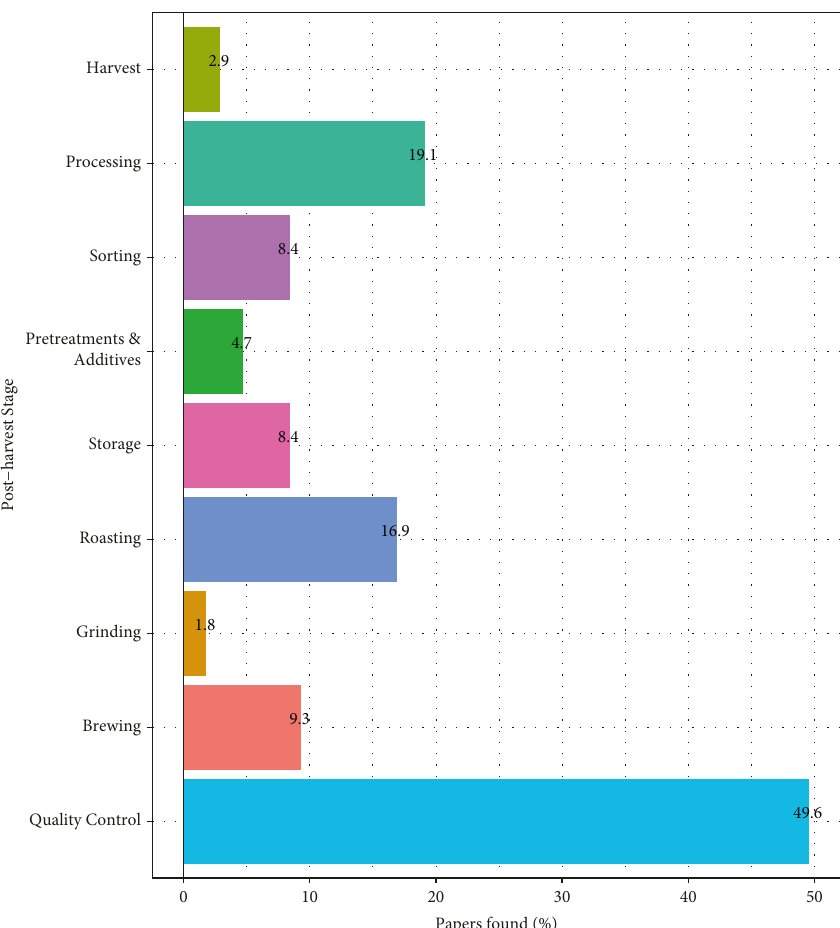
Figure 10: Percentage of the articles centered on the postharvest